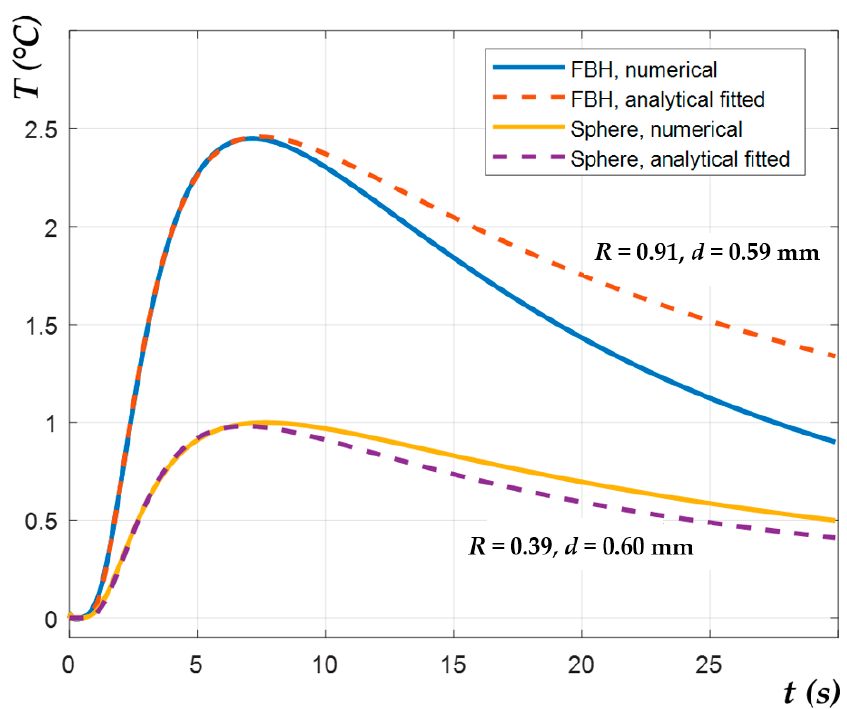
Figure 7. Evolutions of temperature contrasts ∆ T for FBH and spheres with D = 3 mm and d = 0.6 mm obtained by numerical and analytical modelling with fitted d and R parameters.